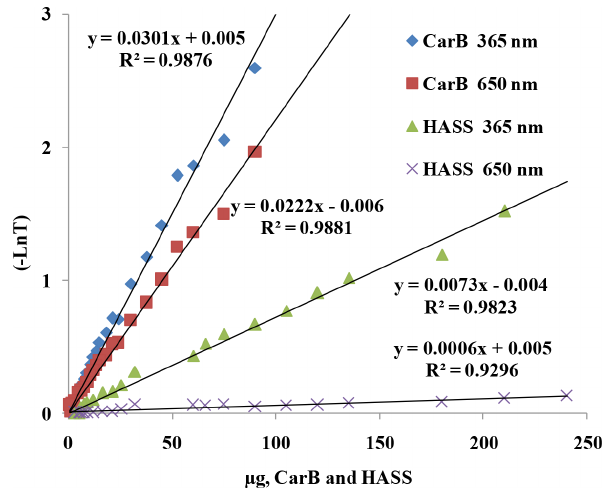
Figure 2. The calibration curves for CarB (carbon black; diamonds and squares) and HASS (humic acid sodium salt; crosses and tri- angles) at 365 and 650nm. T is the transmittance of incident light through calibration